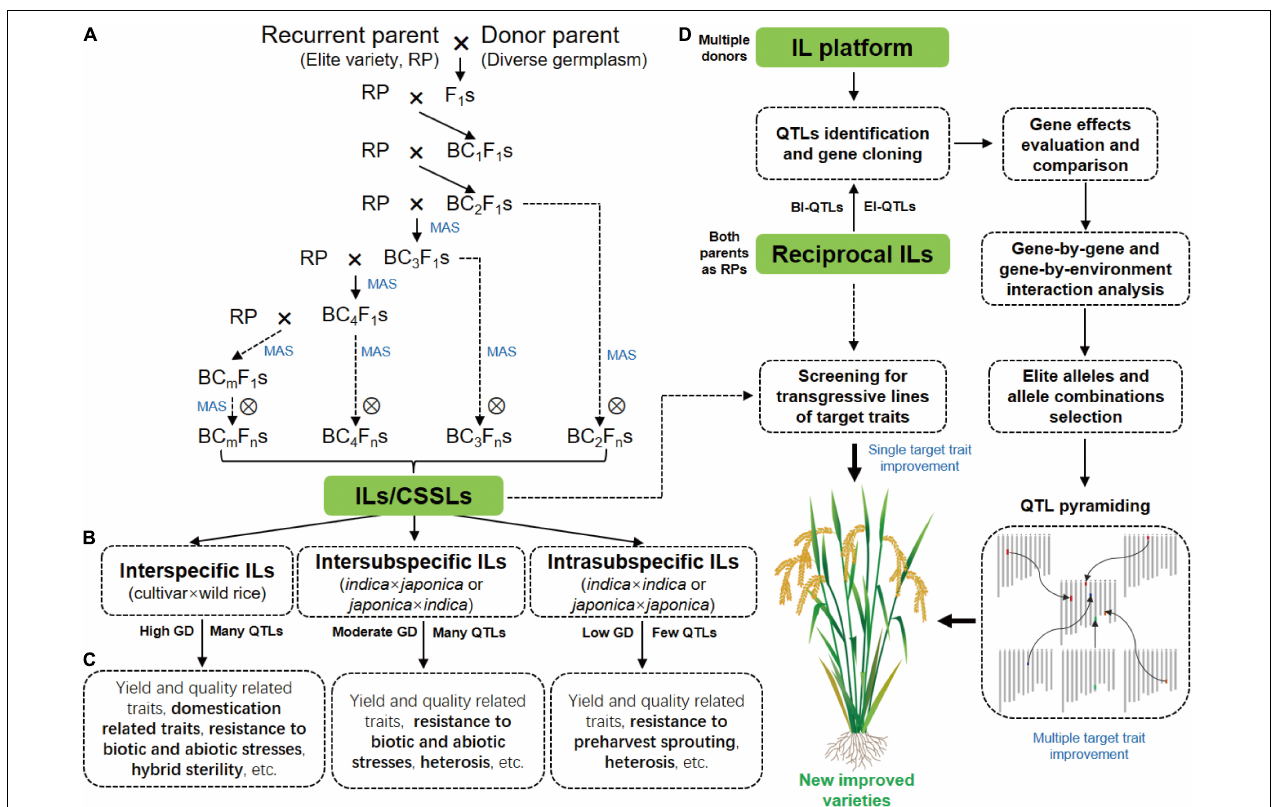
FIGURE 1 | Construction of rice ILs and their application in functional genomics research and breeding. (A) A traditional backcross scheme for ILs/CSSLs development with MAS. (B) ILs with different crossing types. (C) The main traits for genetic dissection by ILs derived from different crosses. The specific traits for the genetic dissection by different ILs are highlighted in bold. (D) The strategy of rice breeding by using ILs or IL platform. GD, genetic diversity; BI-QTLs, background-independent QTLs; E-QTLs, epistatic